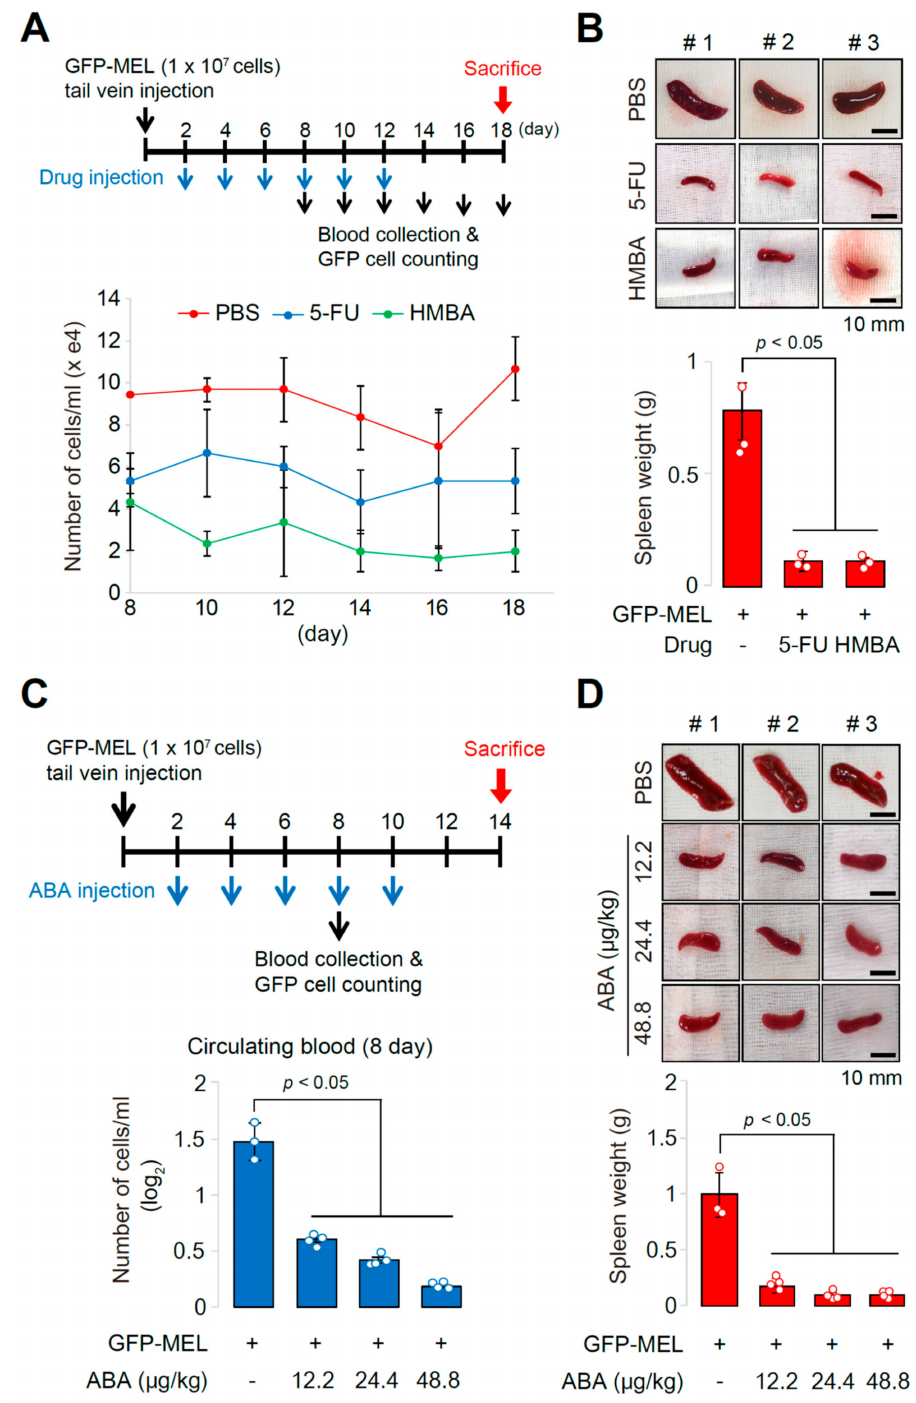
Figure 5. Applicability of the established allograft model and circulating blood analysis method for screening and validation of anti-cancer drugs. ( A ) Timeline of animal experiments for allograft